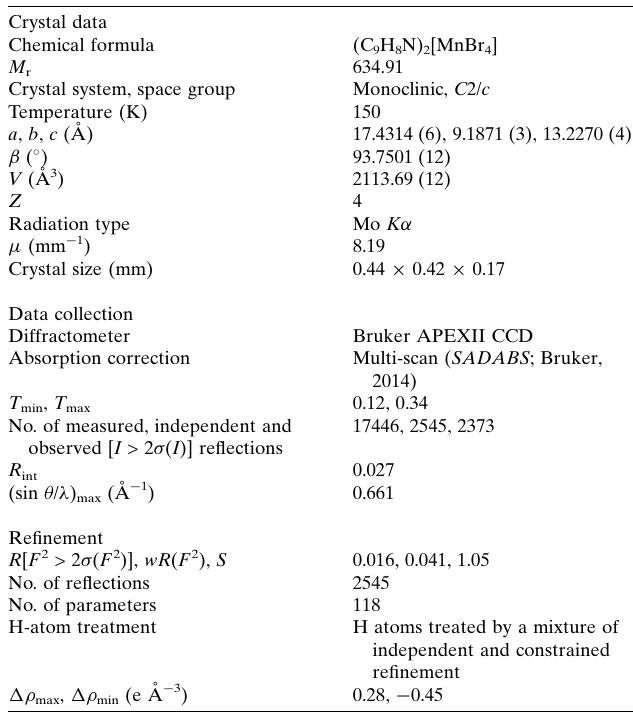
Table 1 Hydrogen-bond geometry (A˚ , (cid:5)